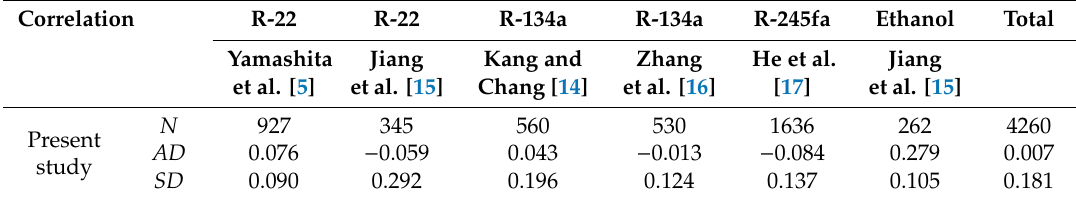
Figure 10. The deviation of pertaining to ( a ) Table 9. Comparisons between the experimental data and the proposed correlation. Correlation